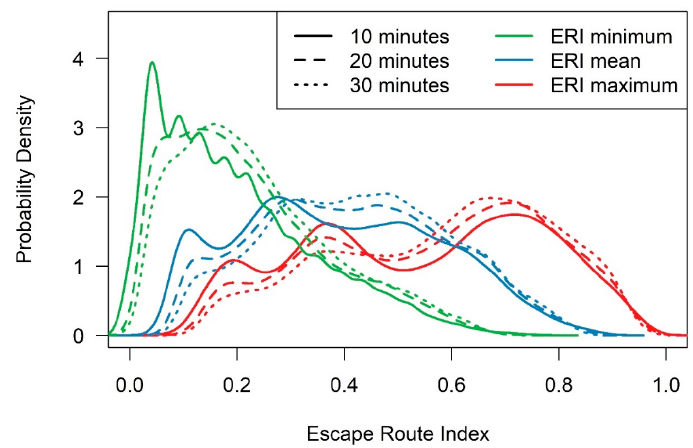
Figure 7. Probability densities of ERI metric raster cell values for each of the time frames tested throughout the ANF. Table 7. Descriptive statistics of ERI metric raster cell values for each of the time frames tested throughout the ANF. SD is the standard deviation.